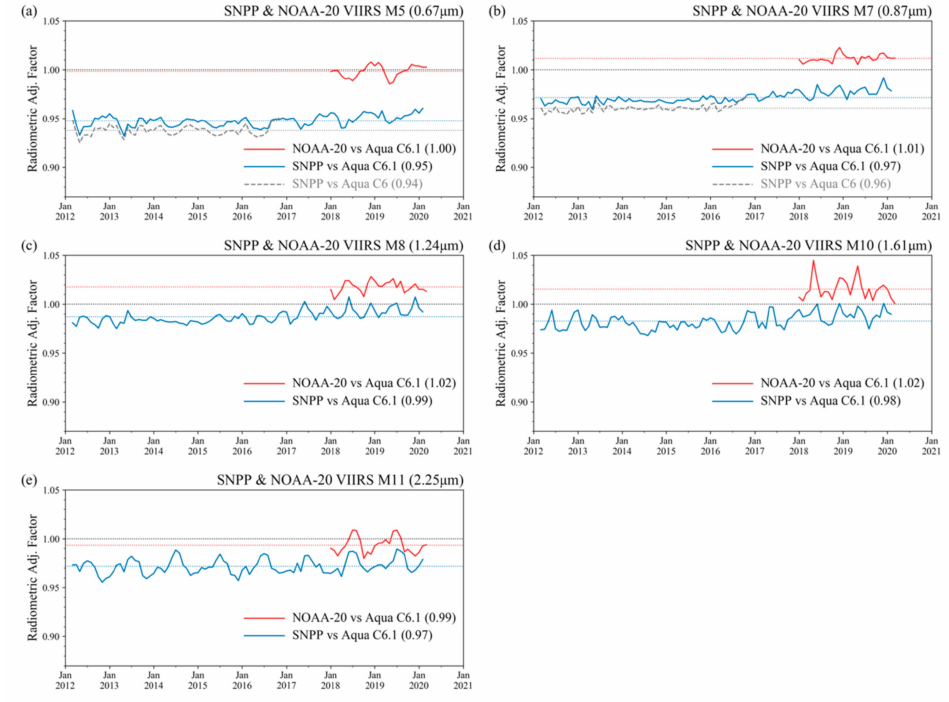
Figure 4. Time series of SNPP (blue lines) and NOAA-20 (red lines) VIIRS spectral radiometric adjustment factors derived for the ( a ) 0.67 (M5), ( b ) 0.87 (M7), ( c ) 1.24 (M8), ( d ) 1.61 (M10) and ( e ) 2.25 µ m (M11) channels. The solid blue and dashed gray lines denote SNPP VIIRS adjustment factors derived using Aqua MODIS C6.1 and C6 L1Bs, respectively, as the reference. The thin dotted lines denote the time series means, with exact values indicated in the